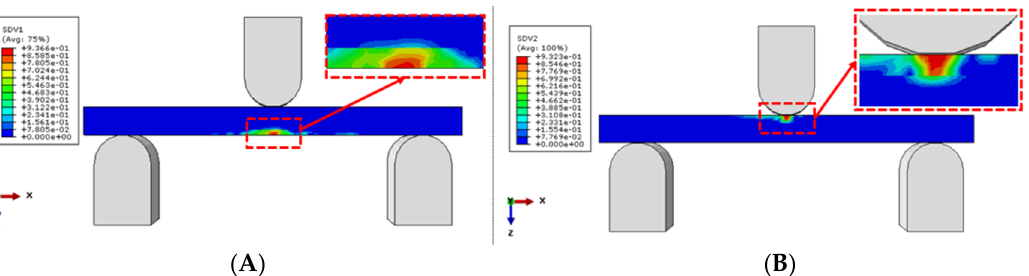
Figure 14. Distribution of the damage variable fields prior to the failure: ( A ) the tension damage, and ( B ) the compression damage.